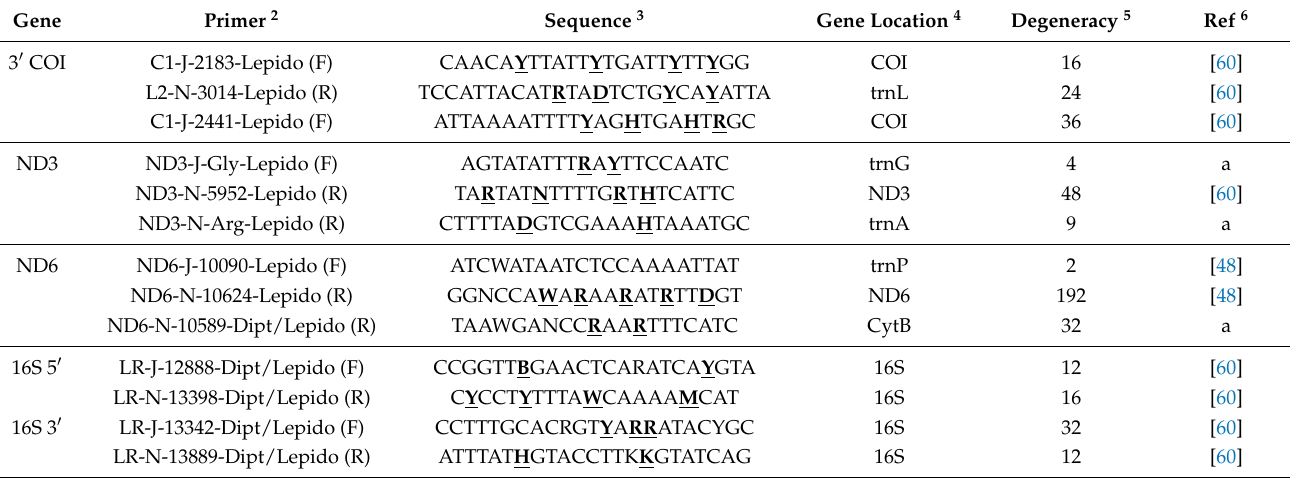
Table 3. All primer sequences for Lepidoptera, either adapted from the literature or de-novo designed based on sequences available in GenBank 1